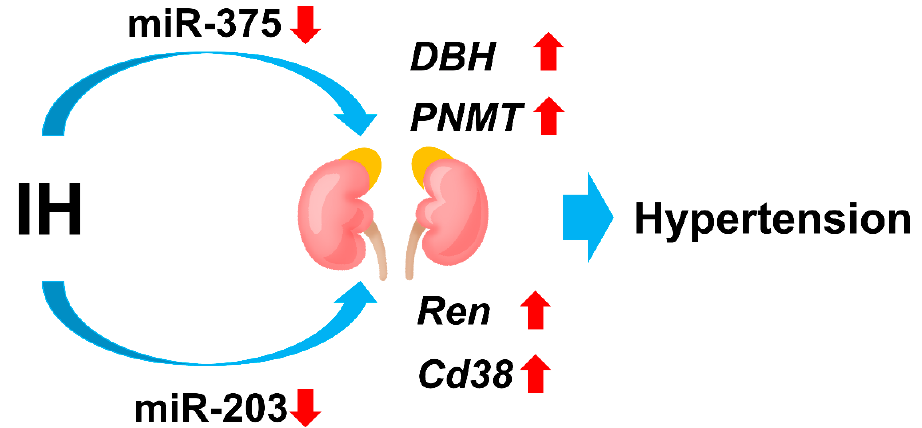
Figure 3. Schematic view of IH on the expression of Ren and Cd38 in renal JG cells and DBH and PNMT in adrenomedullary neuroblastoma cells. IH upregulates Ren and Cd38 mRNAs in renal JG cells by downregulating miR-203 [85] and DBH and PNMT mRNAs in adrenomedullary neuroblastoma cells by downregulating miR-375 [89].